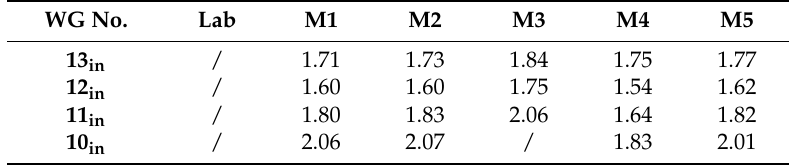
Table 5. The pressures acting inside the reservoir in kPa, with the same abscissa of the pressure transducers related to the uplift pressures.